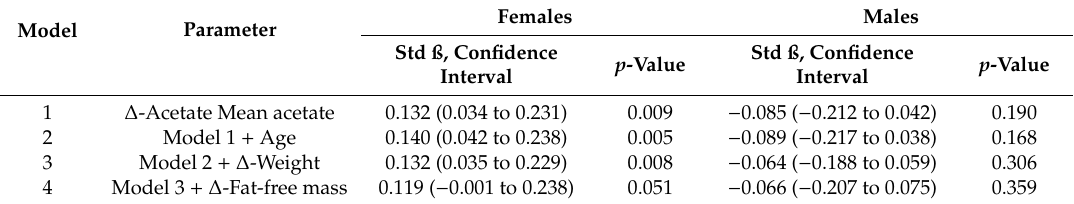
Table 3. Determinants of changes in fasting insulin in participants during weight